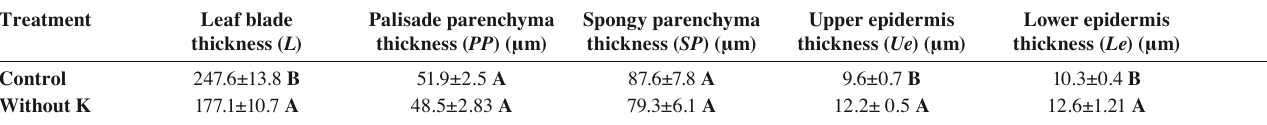
Tab. 4: Anatomical parameters registered in the cross sections of the tree tomato leaves during vegetative growth. Control (without deficiencies) and plants grown without K (potassium deficiency). Means ± standard error (n = 3 per treatment) are presented. Different letters indicate significant statistical differences with a P value <0.05 (the Tukey’s